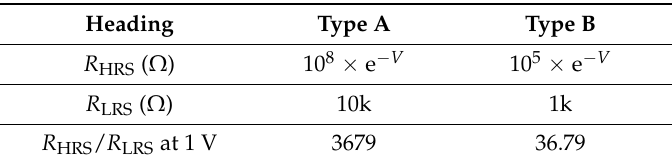
Table 1. Parameters of model